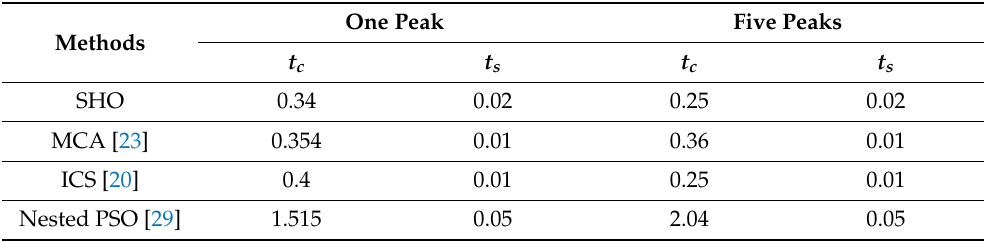
Table 3. Comparative results of SHO, MCA, and improved cuckoo search algorithms for one and five Peaks. Methods